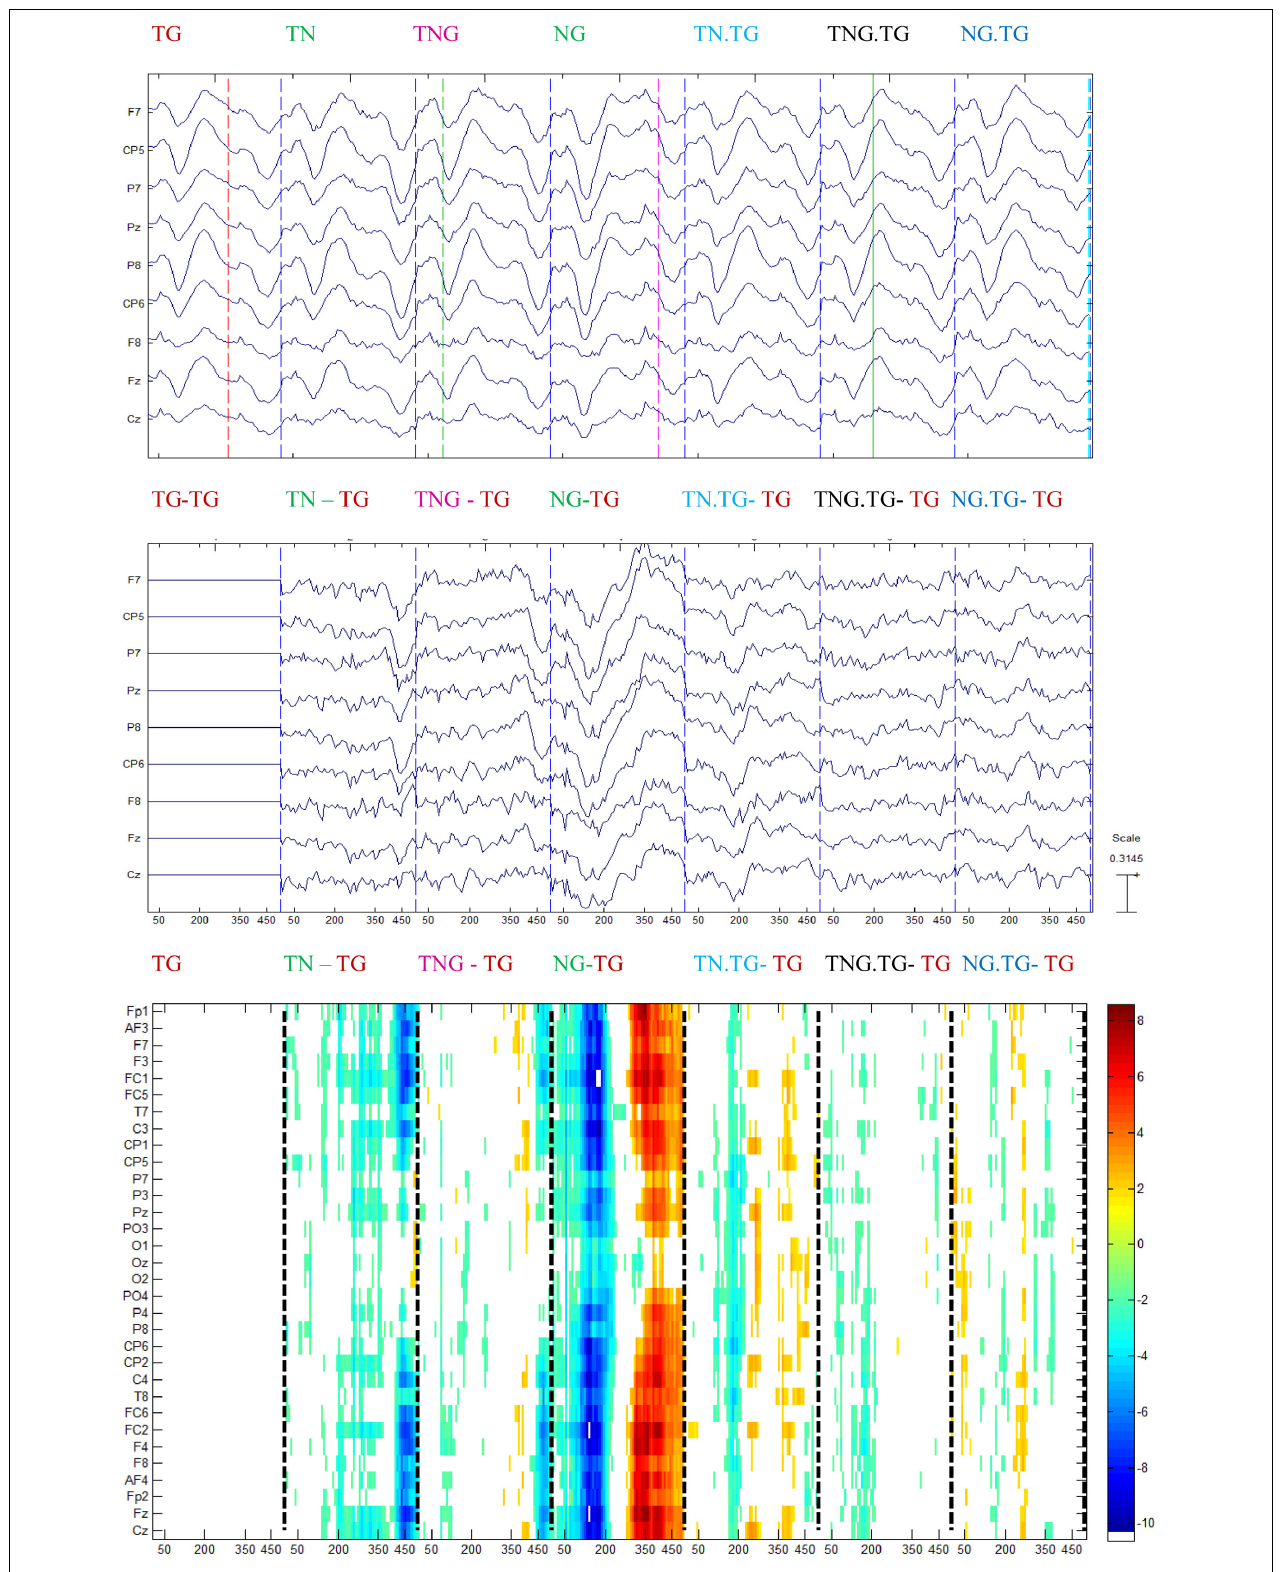
FIGURE 9 | Grand average for schizophrenic patients of the ERP in each condition (top) subtracted with the standard ERP condition in the previous channels (middle) , and the multiple t -test analysis between each condition and the standard followed by the standard ( p < 0.001) (bottom).